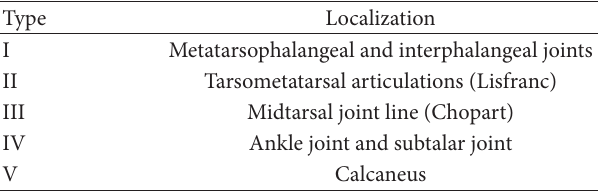
Table 4: Sanders and Frykberg classification.